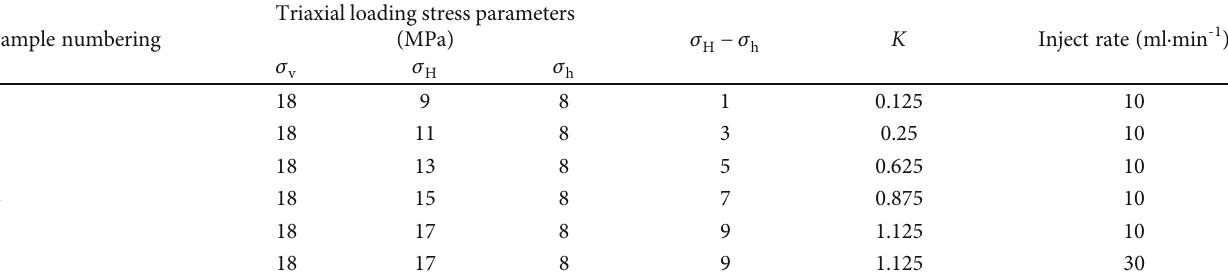
Figure 3: True triaxial hydraulic fracturing physical simulation test system. Table 2: Fracturing test